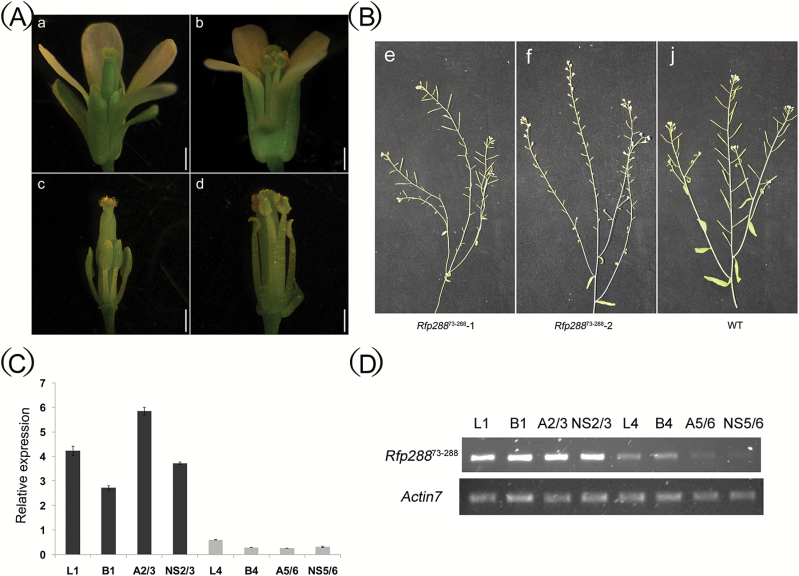
Fertility associated with truncated ORF288 expression in Arabidopsis. (A) Anthers from transgenic truncated orf288 fragments (a, c) and the wild-type (b, d). (B) The siliques from transgenic truncated orf288 fragments (e, f) and the wild-type (j). (C, D) qPCR and RT-PCR analysis of the expression levels of the truncated orf288 fragments in different tissues from transgenic plants. L1 and B1, leaves and floral buds from a transgenic male sterility T3 plants; A2/3, anthers from two transgenic T3 male sterility plants; NS2/3, floral buds without anthers from two transgenic T3 male sterility plants; L4 and B4, leaves and floral buds from a transgenic semi-male sterility T3 plants; A5/6, anthers from two transgenic T3 semi-male sterility plants; and NS5/6, the floral buds without anthers from another two transgenic T3 semi-male sterility plants. (This figure is available in colour at JXB online.)